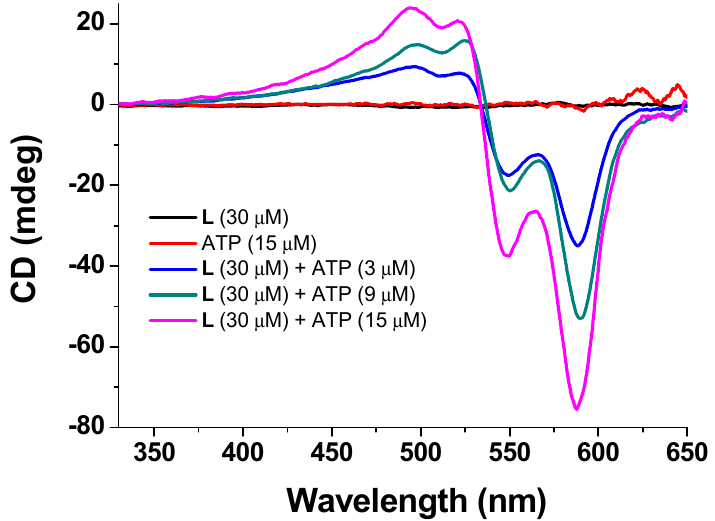
Figure 4. Circular dichroism (CD) spectra of ATP (15 µ M) and L (30 µ M) in the absence and the presence of various amounts of ATP in water (pH 7.4).